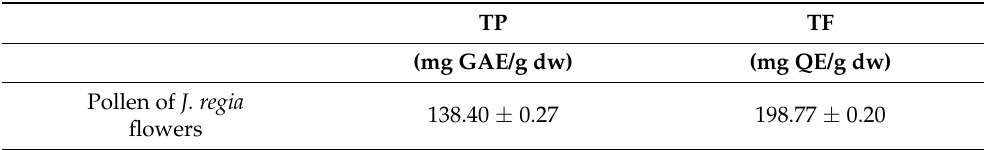
Table 1. The contents of total phenolic and flavonoid of J. regia flowers pollen extracts. TP TF Pollen of J. regia